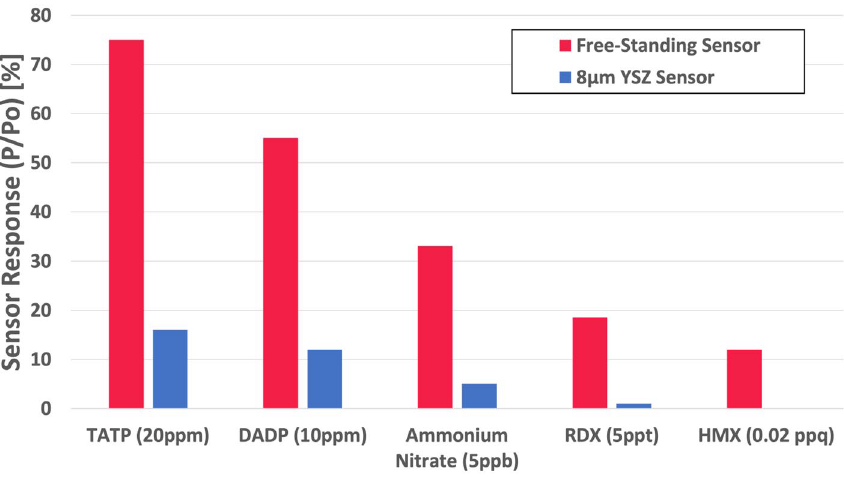
Figure 8. Responses of an 8 µm YSZ sensor and free-standing sensor to a variety of peroxide based explosives as well as nitramines and nitrites at known